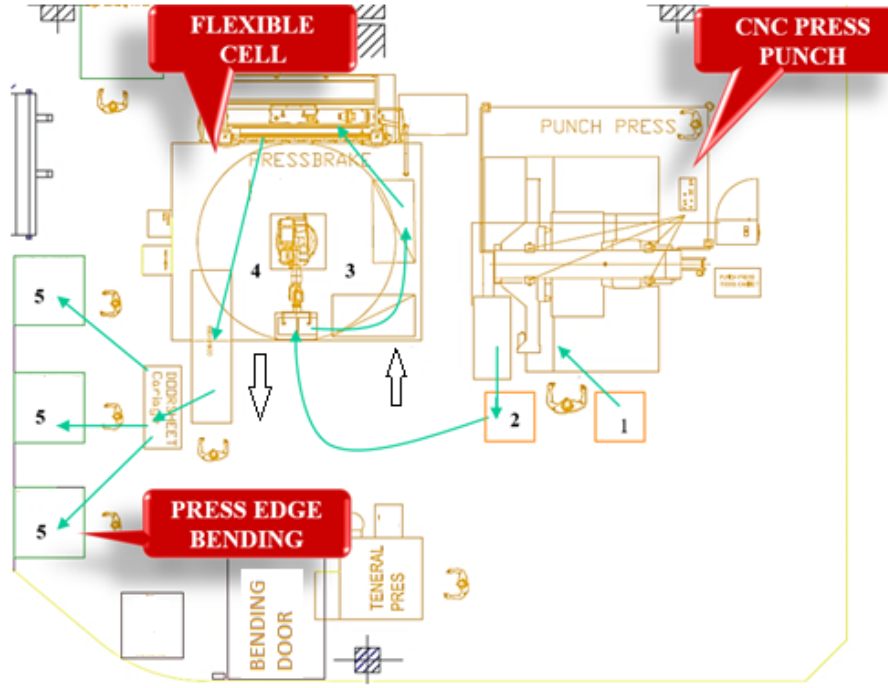
Figure 13. Map of the process.